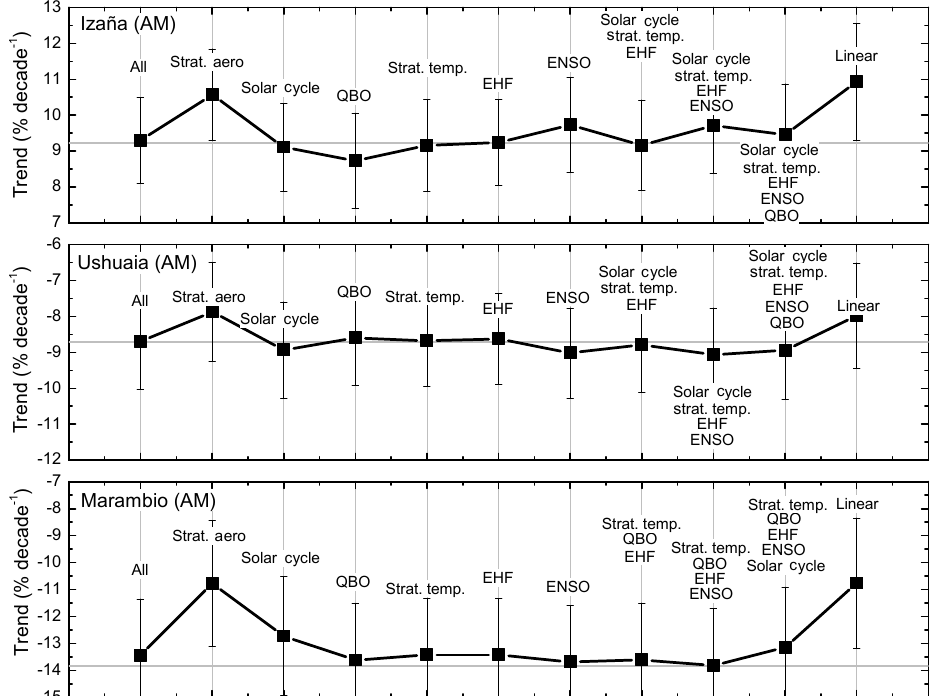
Figure 4. Impact of the computed trends per month depending on the selected proxies. Case “All” means that all proxies are included. Labels indicate the proxy/ies excluded from the analysis. The trend obtained in the final analysis is plotted as a reference (grey line). See the text for details.